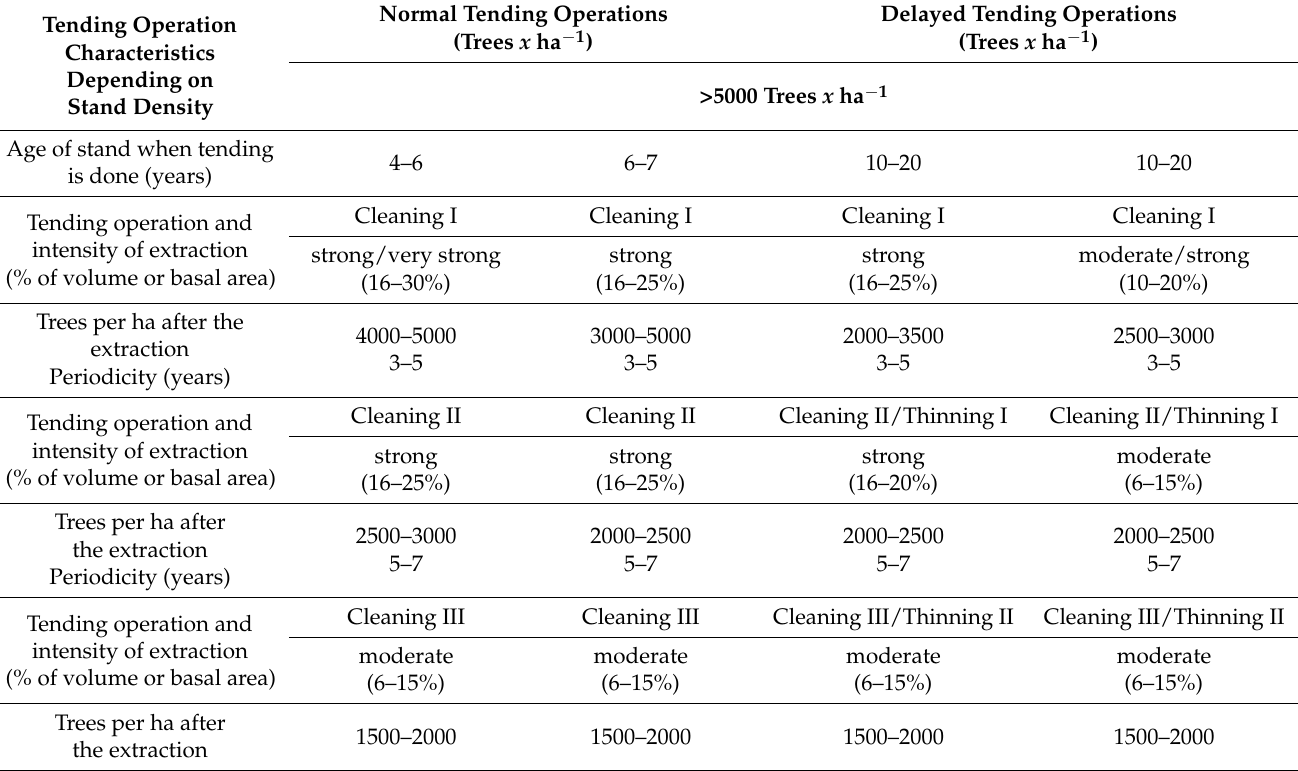
Table 1. Tending operations for black locust stands on degraded lands